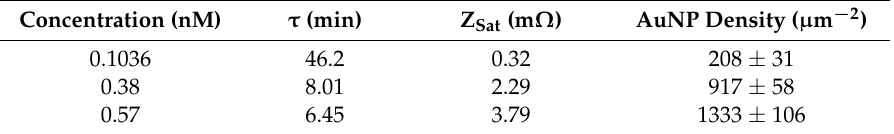
Table 1. Fit parameters determined by the first-order exponential fit function of MPA–AuNP binding for different concentrations. In addition, the final MPA–AuNP densities per µ m − 2 determined by SEM analysis are given.